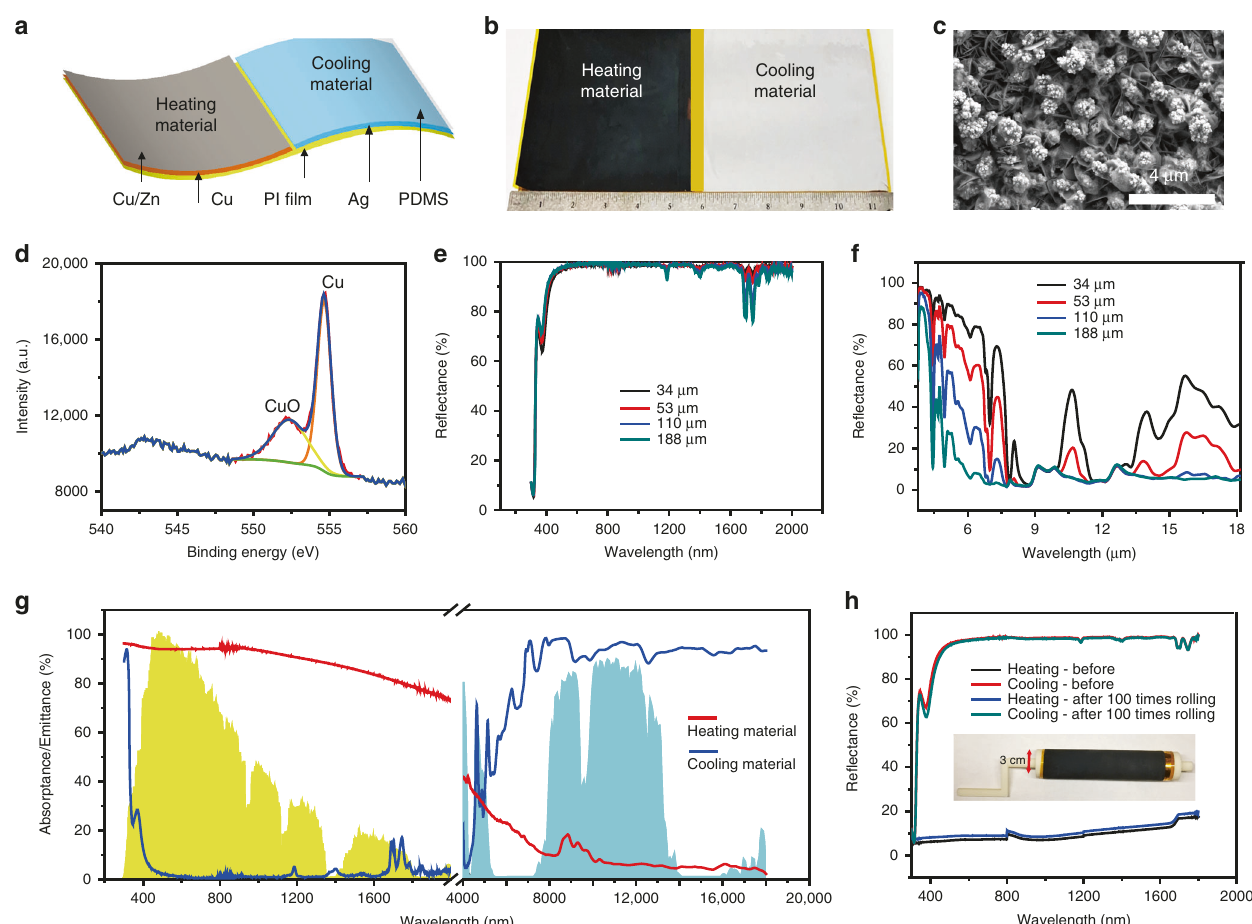
Fig. 3 Dual-mode material structure and properties. a Structure of dual-mode heating/cooling material. Polyimide (PI) is the common substrate. Above the PI substrate, different con fi gurations are used for the two modes. For cooling mode, Ag fi lm is the electrode for exerting the electrostatic force (Maxwell pressure) and for re fl ecting the solar radiation. The top PDMS layer is visibly-transparent and infrared-emissive for radiative cooling. For heating mode, Cu is the electrode for supplying static charge, and the Cu/Zn is the plasmonic selective absorber. The thickness of PDMS, Cu/Zn, Ag, Cu, and PI fi lm are 110 µ m, 1 µ m, 300 nm, 300 nm, and 25 µ m, respectively. b The photo of the dual-mode material shows the different visible appearance of the heating/cooling parts ( c ), SEM image of the heating material. d XPS spectrum of a copper particle on heating material. e , f Visible, near-IR, and mid-IR re fl ectance spectra of cooling materials of different thicknesses. g Absorptance/emittance of dual-mode material. Solar spectrum (yellow shaded area), and atmospheric transmittance window (green shaded area) are plotted for references. h The re fl ectance of heating and cooling material before/after 100 times rolling testing. The inset is the photo of the sample under